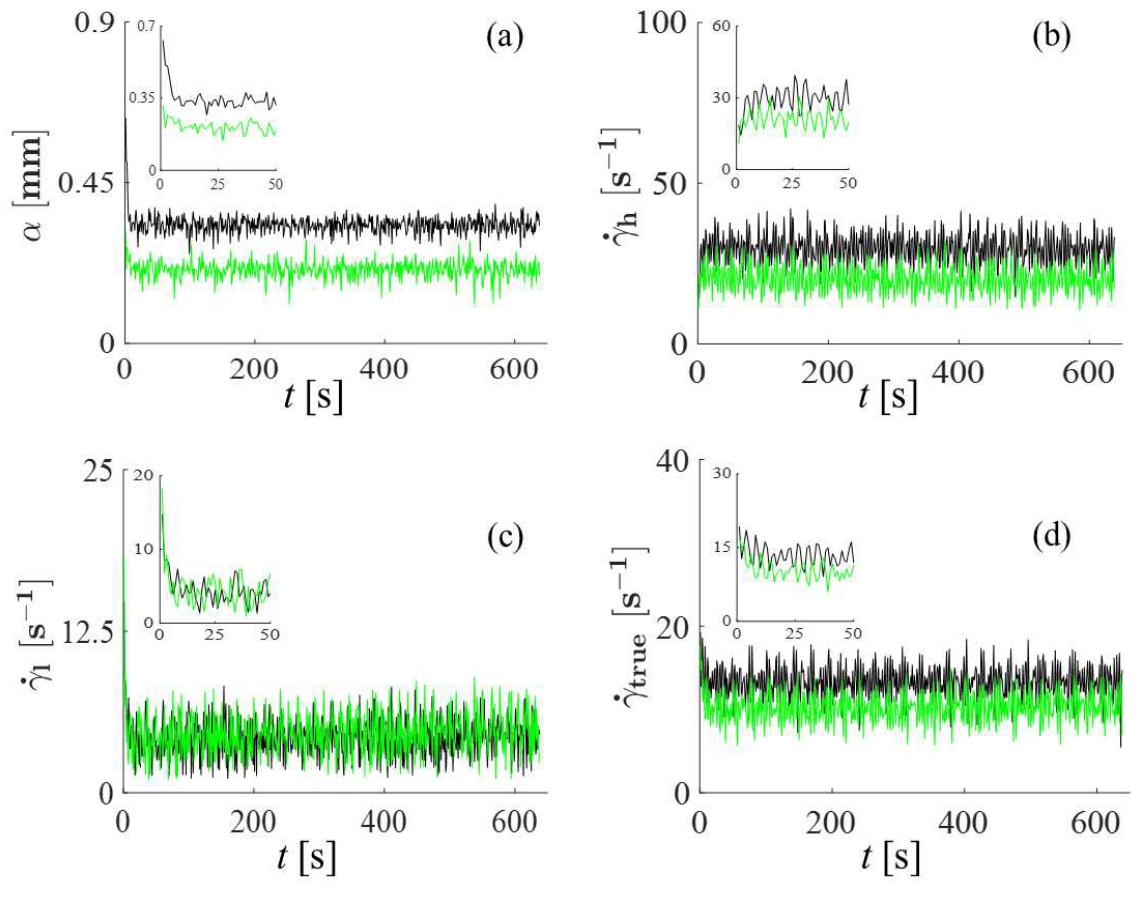
Figure 4: (a) the interface position α , (b) the shear rate in the high shear band ˙ 𝛾 h , (c) the shear rate in the low shear band ˙ 𝛾 l and (d) the true shear rate ˙ 𝛾 obtained from 1D velocity profiles acquired every 1 s as a function of time following shear startup to 15 s −1 . The black line is true protocol 1 (no pre-shear) and the green line is protocol 2 (with pre-shear). The evolution from transient to steady state values is visible in the first 50 seconds (shown in the insets) as well as large fluctuations with time for the entire acquisition duration.